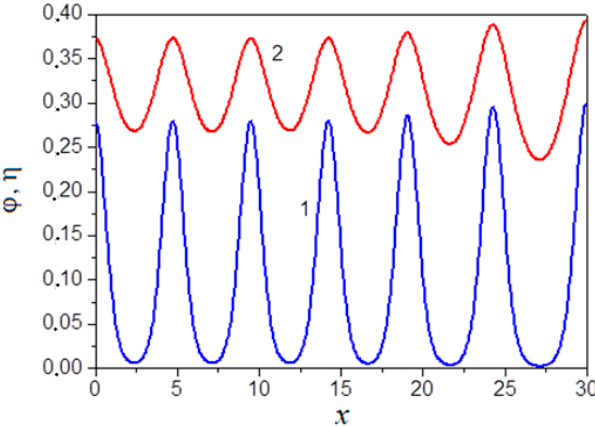
Figure 5. Spatial distribution of the variables 𝜑 (curve 1) and η (curve 2) on 𝑙 (cid:2870) = 2.1 .